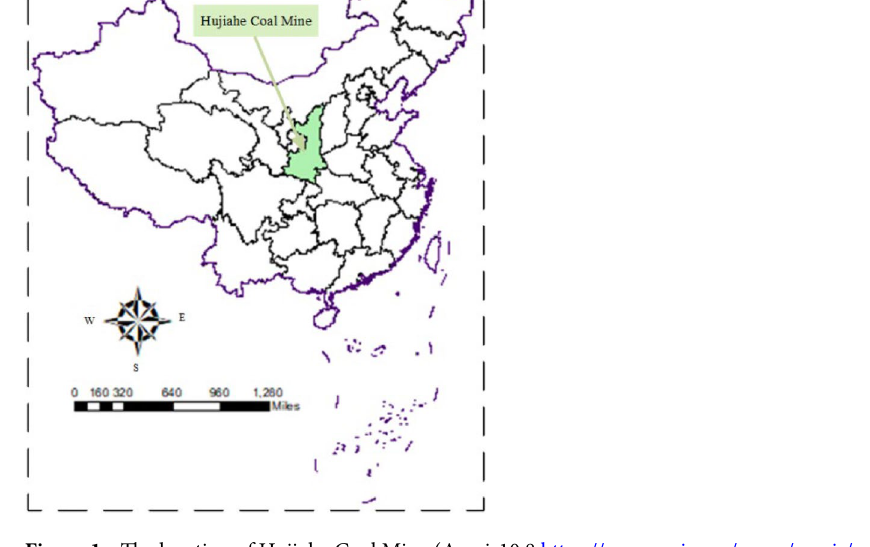
Figure 1. The location of Hujiahe Coal Mine (Arcgis10.8 https:// www. esri. com/ en- us/ arcgis/ produ cts/ mappi ng/ overv